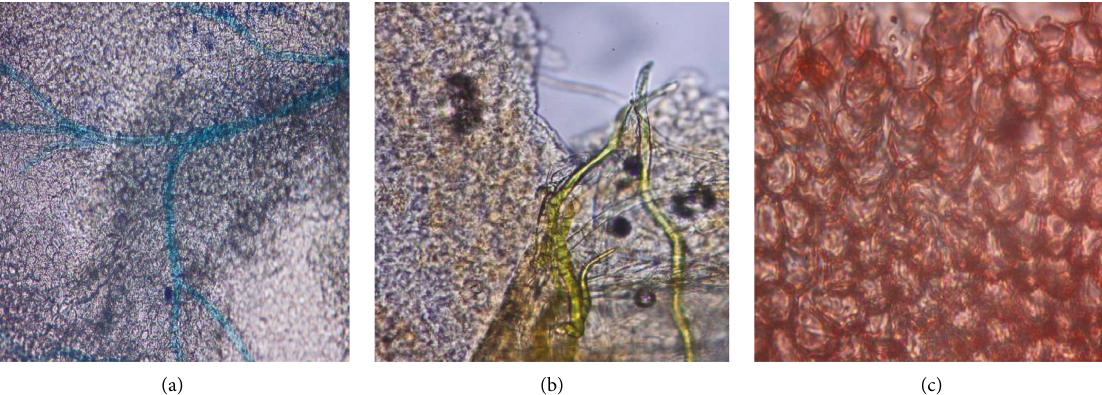
Figure 3: Result of histochemical reactions of flower petals and petals from buds: (a) methylene blue solution (magn. × 100); (b) sodium hydroxide (magn. × 400); (c) Sudan III reagent (magn. × 400).